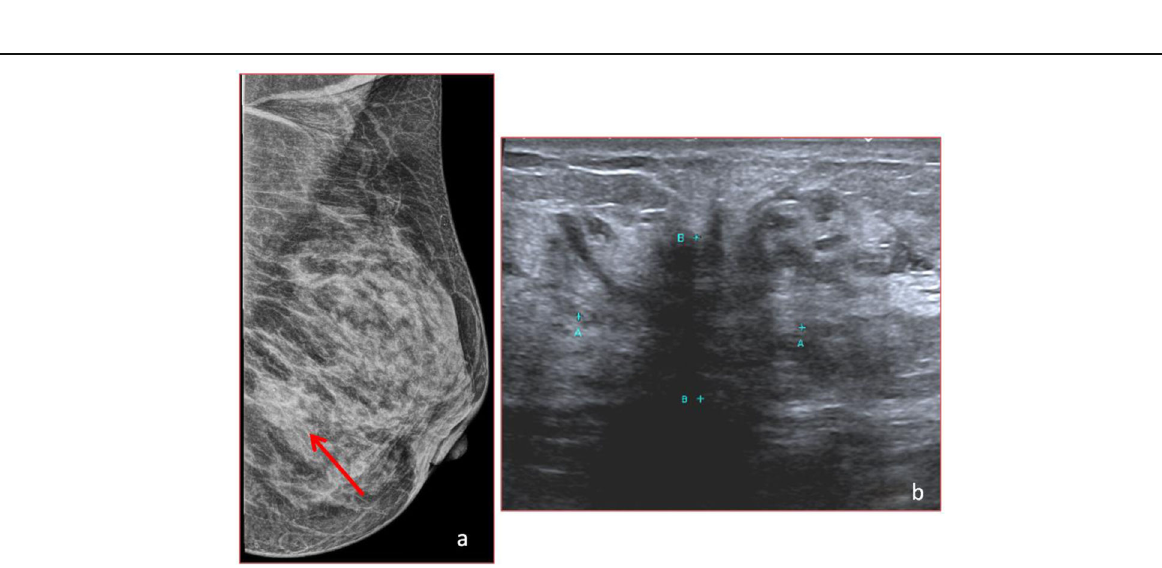
Fig. 5 a X-ray mammogram in medio-lateral oblique view showing irregular equal density lesion with partially obscured borders. b High resolution ultrasound showing hypoechoic irregular lesion with